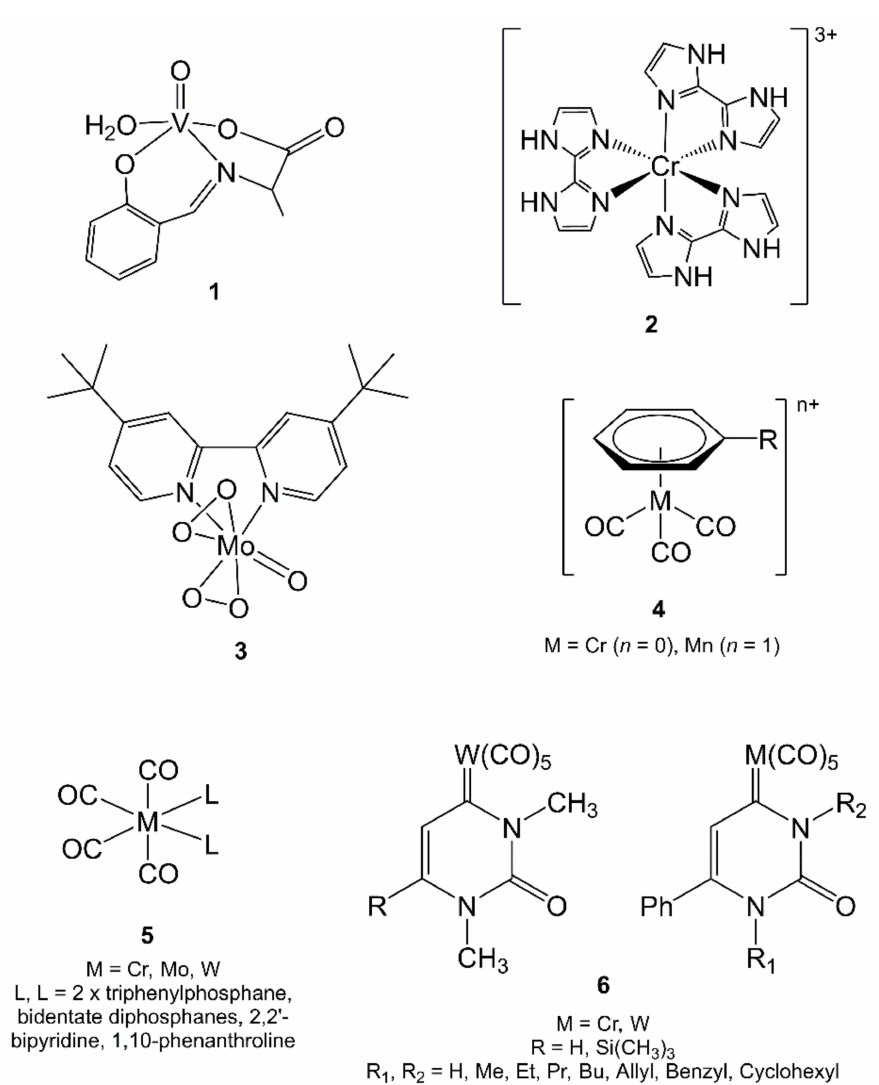
Figure 3. A selection of complexes containing V, Cr, Mo, W, and Mn cited in the